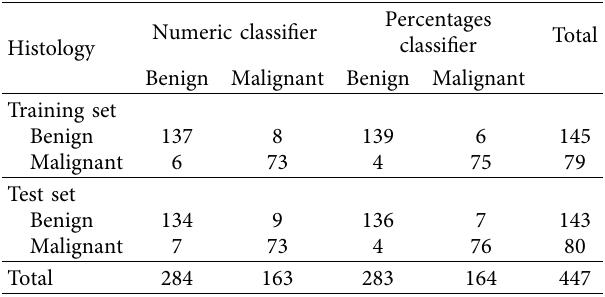
Table 6: Cross-tabulation of the patient classification subsystem for the numeric and percentages classifiers separately for the training and test